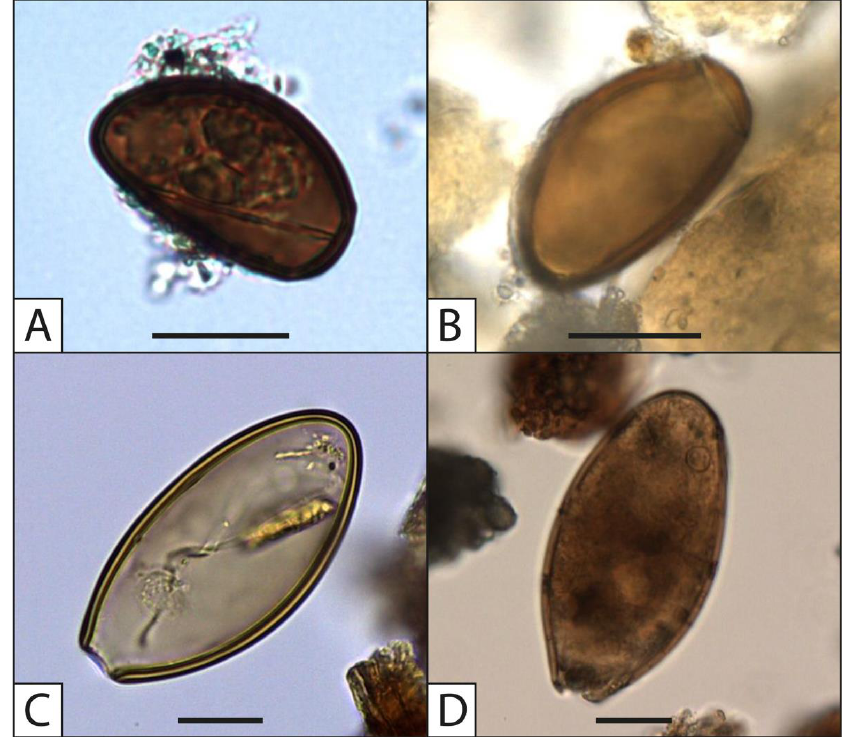
Figure 5. Eggs from the oldest and most recent period observed in the Besançon laboratory: ( A ) Lancet liver fluke egg from Concise (Neolithic period, Switzerland), 41.48 µm × 24.59 µm; ( B ) Lancet liver fluke egg from Reims (Modern period, France), 42.78 µm × 23.12 µm; ( C ) Oxyuris equi egg from Berel (Iron Age, Kazakhstan), 84.28 µm × 43.12 µm; ( D ) Oxyuris equi egg from Bourges (Medieval period, France), 85.65 µm × 45.23 µm. Scale bars, 20 µm.